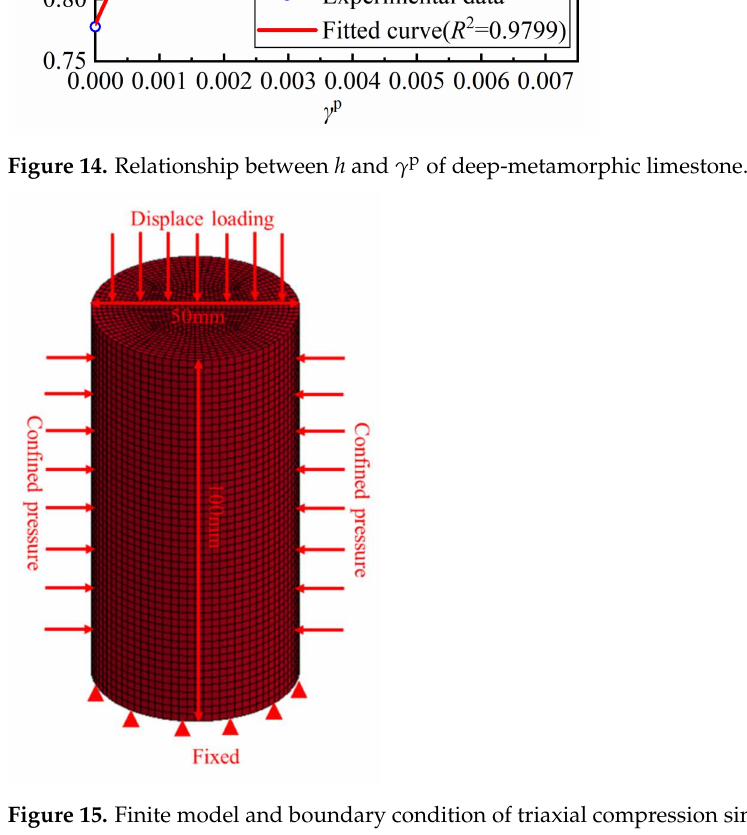
Figure 15. Finite model and boundary condition of triaxial compression